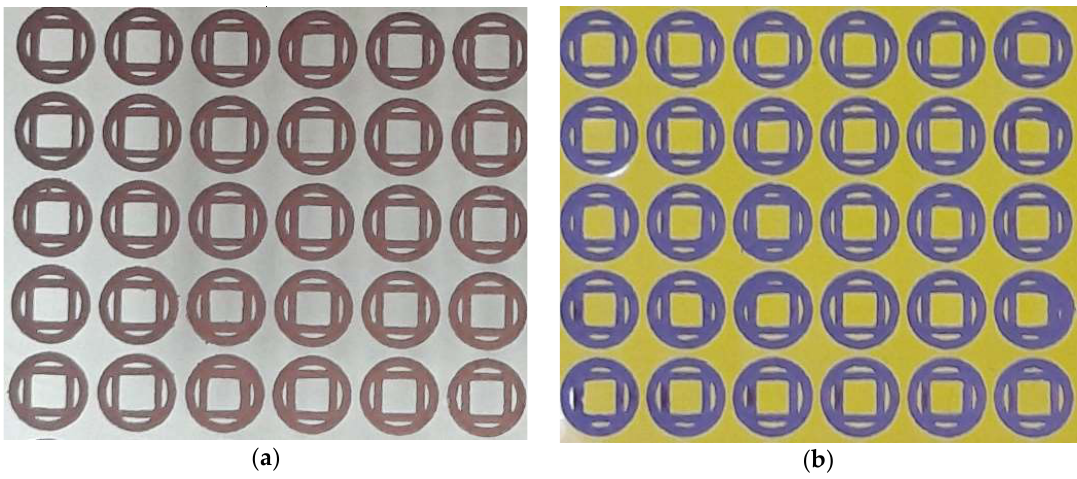
Figure 3. Images of small segments from the extended geometries of fabricated prototypes of 60-GHz metasurface: ( a ) Printed prototype of Melinex, ( b ) Printed prototype on Kapton.